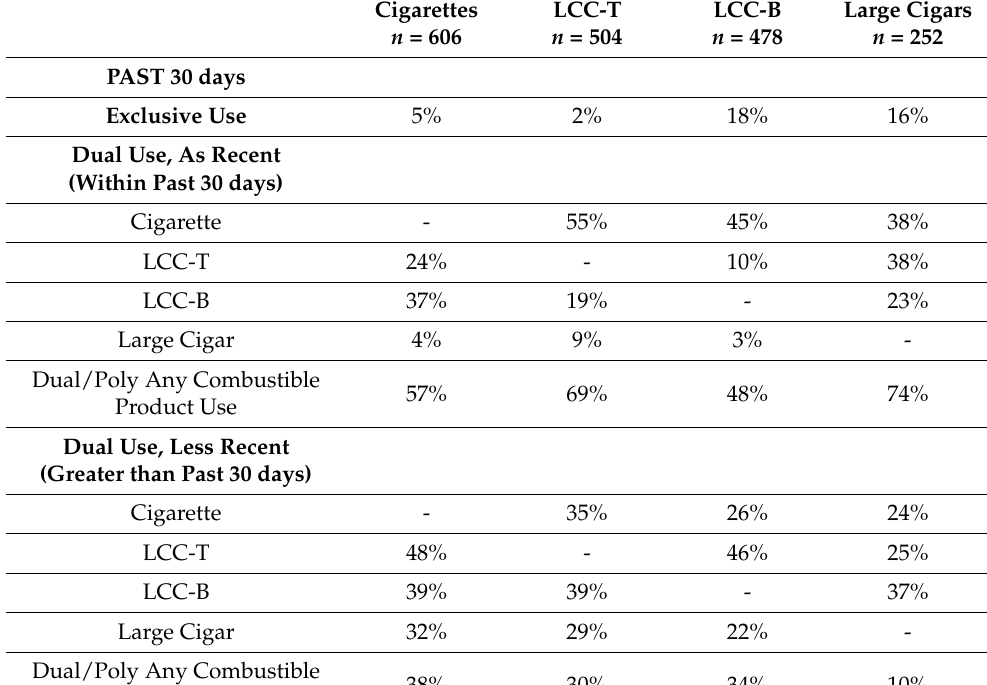
Table 3. Consumption Taxonomy of Exclusive, Dual, and Poly Combustible Tobacco Use Among Young Adults, Weighted to U.S.-Representative